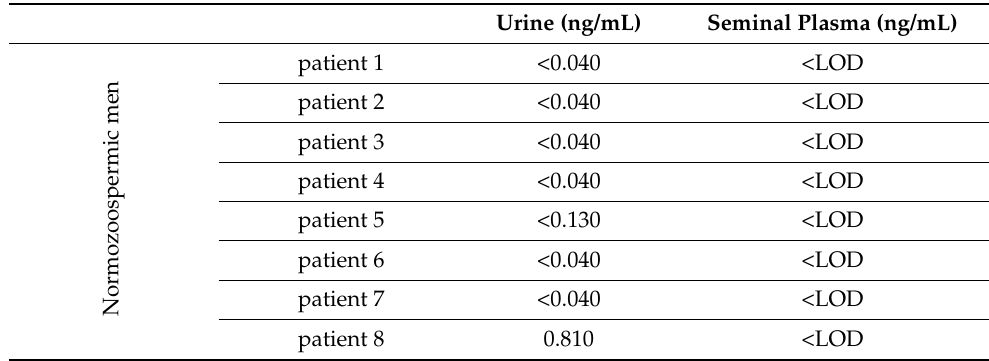
Table 4. Detection of bisphenol F (BPF) in all the observed patients in urine and in seminal plasma. LOD = limit of